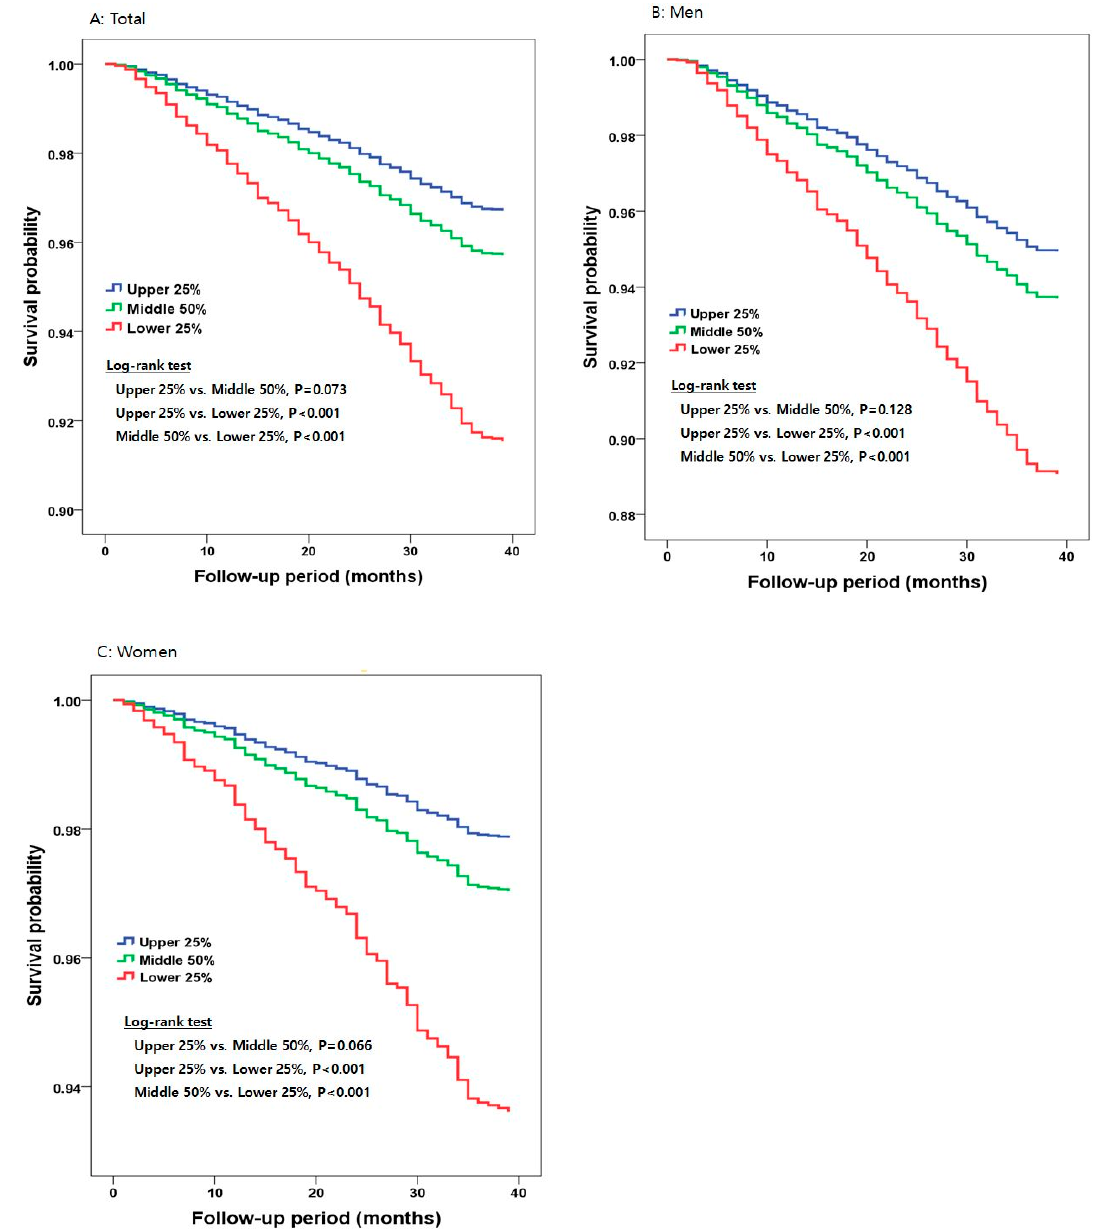
Figure 1. Survival curves according to eCRF categories in total ( A ), men ( B ), and women ( C ).